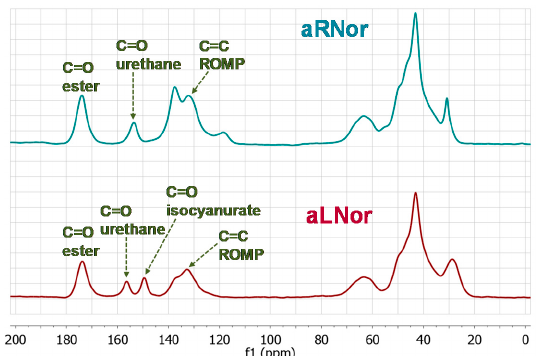
Figure 9. 13 C-CPMAS NMR spectra of aliphatic (aLNor) and aromatic (aRNor) aerogels.